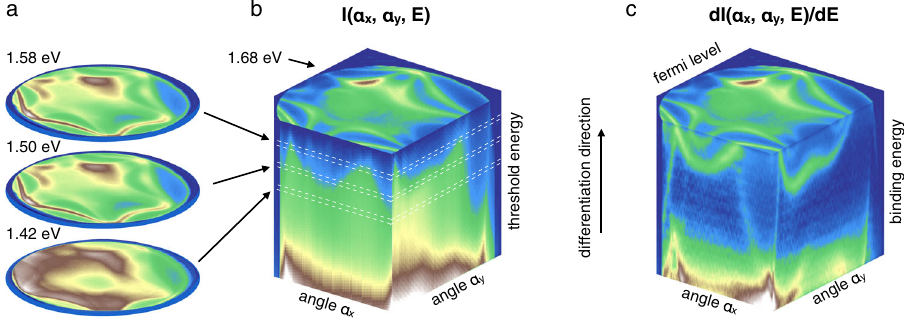
Fig. 4 Electronic dispersion from differentiation. a Exemplary angular distributions of the intensity in Bi 2 Te 3 recorded at different threshold energies. Angular map taken at 1.68 eV corresponds to the Fermi level. b Three-dimensional intensity distribution consisting of 73 layers measured with 10 meV steps. Background intensity above the Fermi level is not shown. Acquisition time ~30 min. Laser, 6 eV. T = 3 K. c Derivative of the dataset shown in b along energy axis. Top maps in b and c are the same since there is no intensity above the Fermi